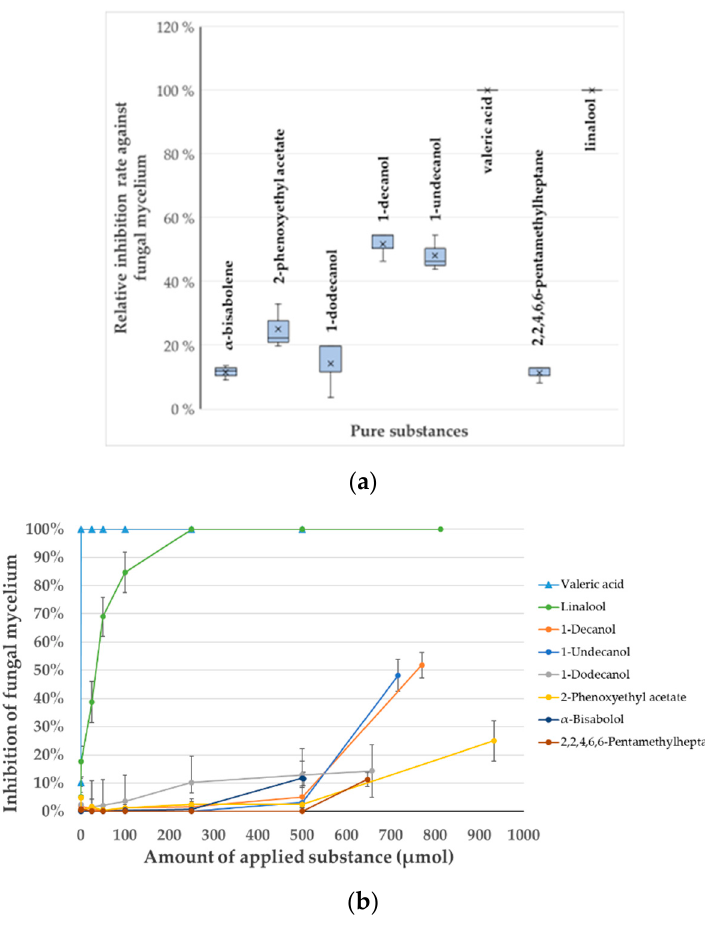
Figure 3. Antagonistic effect of pure compounds on F. culmorum as determined by the Petri Dish VOCs Assay (PDVA). ( a ) Relative inhibition rates of detected VOCs as compared to an empty polytetrafluoroethylene (PTFE)-lined silicon rubber septum against fungal mycelium are displayed in percent. The box plots show the median (-), the mean (×) and the standard deviation (whiskers) of samples; sample size for fungal mycelium n = 5 and for fungal spores n = 3. ( b ) Growth inhibition of fungal mycelium in percent for the identified VOCs at different concentrations as mean values with standard deviation, n = 3.